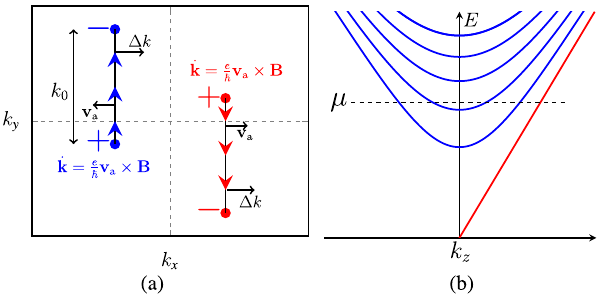
FIG. 1. (a) Fermi arcs in the surface Brillouin zone for a time- reversal-invariant Weyl SM. For simplicity, we ignore the curvature of the arcs and consider straight arcs that are directed along the y axis. The extent of the arcs is k 0 . The red dots denote pair of Weyl nodes with a positive or negative chirality. The blue dots denote their time-reversal partners. The electron velocity v a is perpendicular to the arc at each point. Within the straight arcs approximation, the magnitude of j v a j ≡ v a is independent of k . In the presence of a perpendicular magnetic field, the surface electrons “ slide ” along the Fermi arcs towards the negative chirality Weyl node. An electric field pulse in the x direction leads to a momentum shift Δ k ; i.e., the right arc is slightly populated while the left arc is depopulated. (b) Bulk LL near one of the Weyl nodes. The red line denotes the chiral LL.